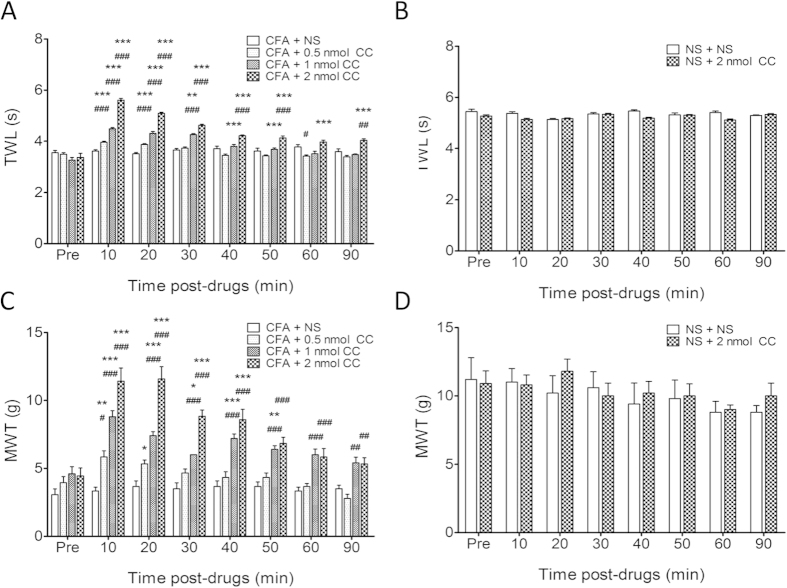
Inhibition of PKC signalling by chelerythrine (CC) attenuates pain behaviour in CFA-injected rats.(A) CC decreased thermal hyperalgesia in CFA rats. Latency of thermal withdrawal responses (TWL) increased 10 min after injection and lasted for more than 30 min. CC at the dose of 2 nmol had the maximal analgesic effect on paw withdrawal latency in CFA rats. (B) CC at the dose of 2 nmol failed to produce any effect on paw withdrawal latency of age-matched control rats. (C) CC decreased mechanical hyperalgesia in CFA rats. Mechanical paw withdrawal threshold (MWT) increased 10 min after microinjection and lasted for more than 30 min. CC at the dose of 2 nmol produced the maximal analgesic effect on MWT in CFA rats. (D) CC at the dose of 2 nmol failed to cause any effect on MWT of age-matched control rats. *p < 0.05, **p < 0.01, ***p < 0.001 vs. pre-drug; #p < 0.05, ##p < 0.01, ###p < 0.01 vs. CFA + NS.